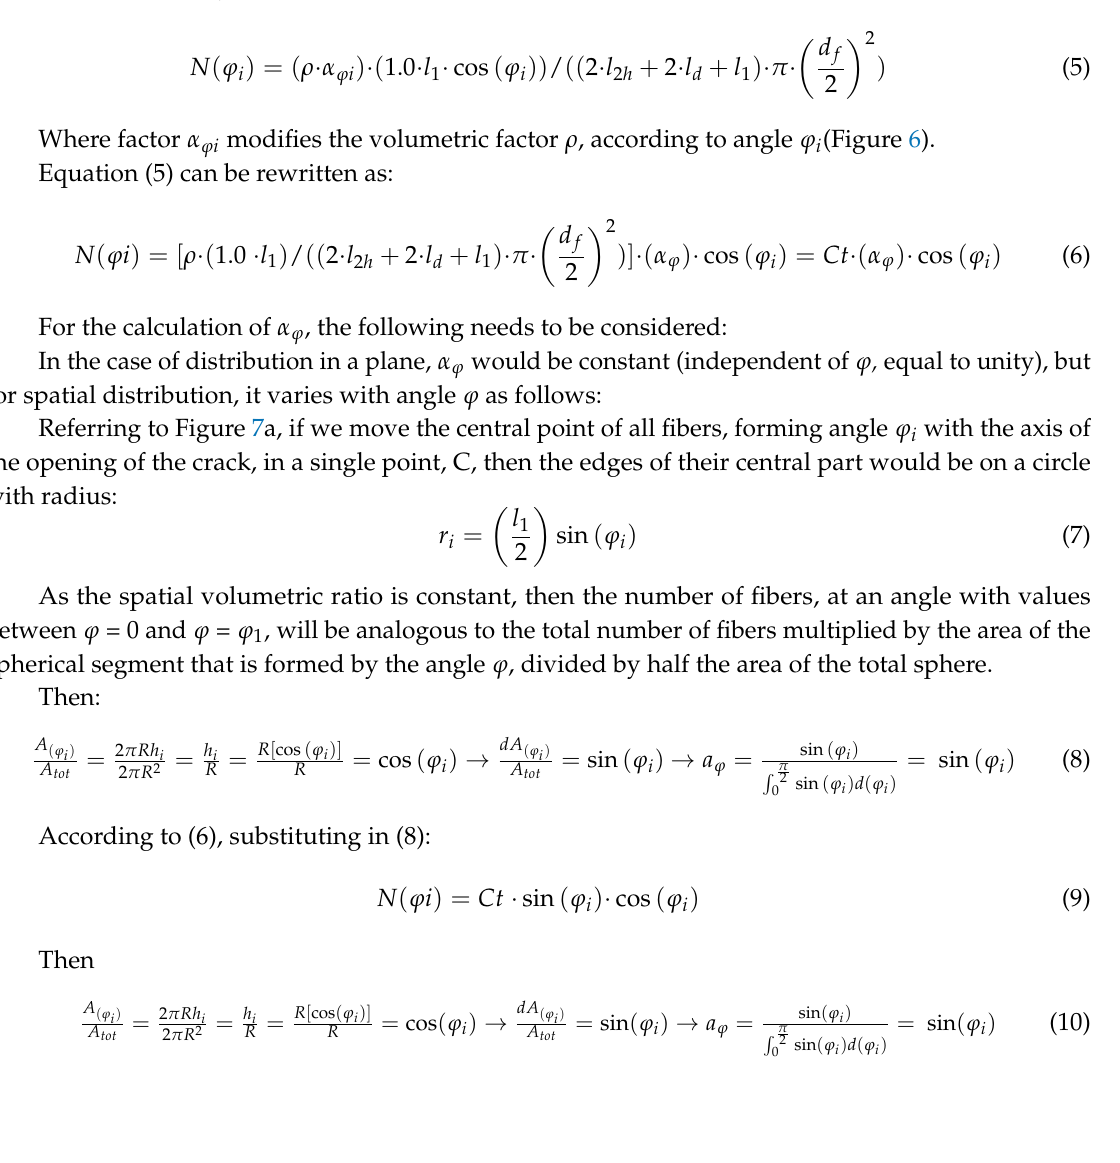
Figure 6. Width (w) of strip that includes the center point of all fibers with orientation angle ϕ to the plane of the crack (P) that they cross.